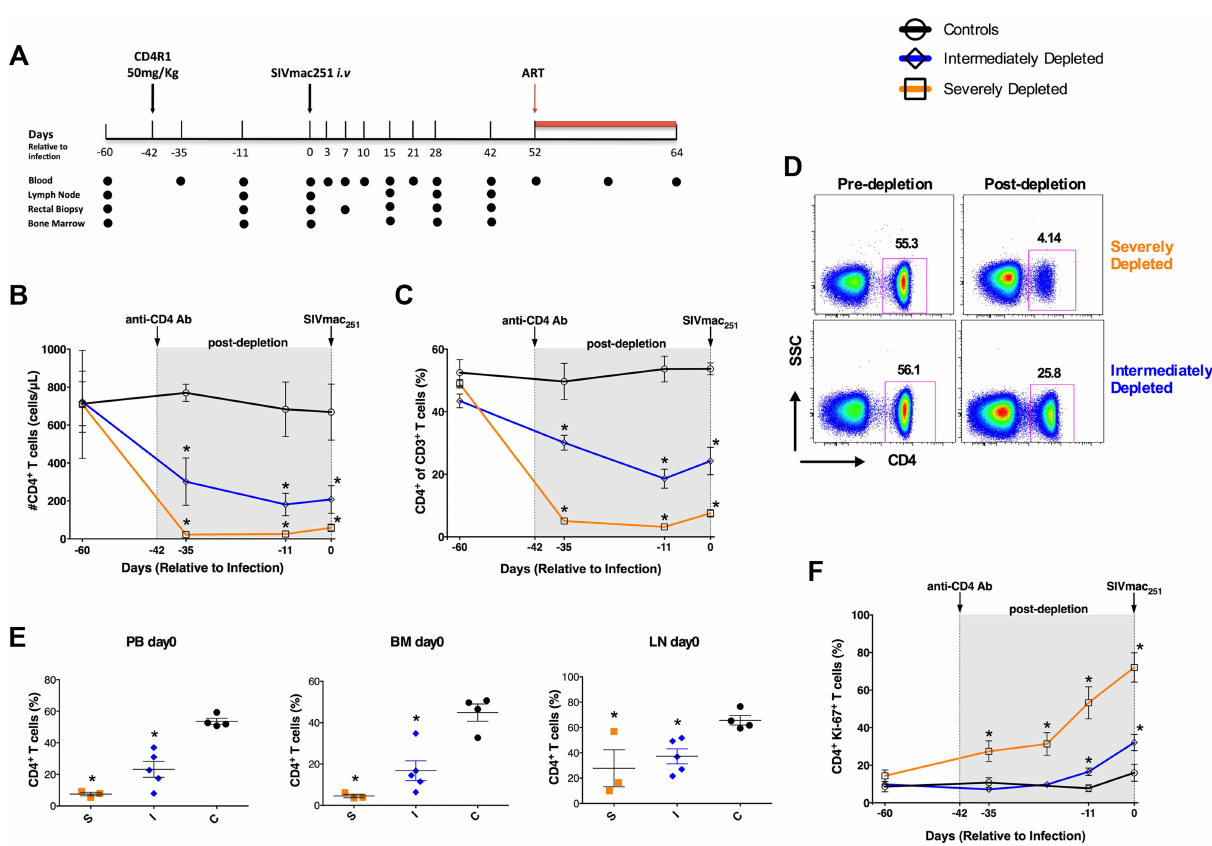
Figure 1. Study design and extent of CD4 + T-cell depletion induced by CD4R1. ( a ) Time line of the study indicating the days in which CD4R1 was administered, SIVmac251 infection performed, and ART initiated, as well as the experimental points at which blood (PB), bone marrow (BM), lymph nodes (LN) and rectal biopsies were collected. ( b,c ) Longitudinal levels (mean 6 S.E) of the circulating CD4 + T-cells expressed as absolute number ( b ) or fraction ( c ) of CD3 + T-cells in severely depleted (orange square; n=3), intermediately depleted (blue diamond; n=5) or undepleted control (black circle; n=4) RMs. In both severely- and intermediately-depleted RMs, the percentage and absolute count of CD4 + T-cells were significantly lower (P , 0.01) than controls at all experimental points post-depletion. ( d ) Representative flow plots showing the fraction of CD4 + T-cells pre- and post-depletion (day 2 11) in one severely (top) and one intermediately (bottom) depleted RMs. ( e ) Levels of CD4 + T-cells expressed as fraction of CD3 + T-cells in PB, BM and LN immediately before SIV infection (day 0) in severely depleted (S; n=3), intermediately depleted (I; n=5) or control (C; n=4) RMs. In both severely- and intermediately-depleted RMs, the percentages of CD4 + T-cells were significantly lower (P , 0.01) than controls. ( f ) Longitudinal levels (mean 6 S.E) of the fraction of circulating CD4 + T-cells expressed Ki-67 in severely depleted (n=3), intermediately depleted (n=5) or control RMs (n=4). The gray box in the graphs of panels b, c, f indicates the post-depletion, pre-infection window. *P , 0.01.